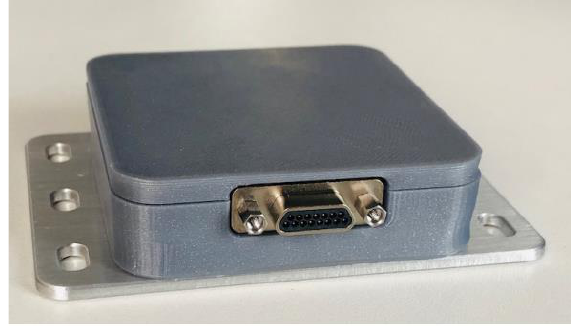
Figure 3. SpW-to-UWB WIU hardware.